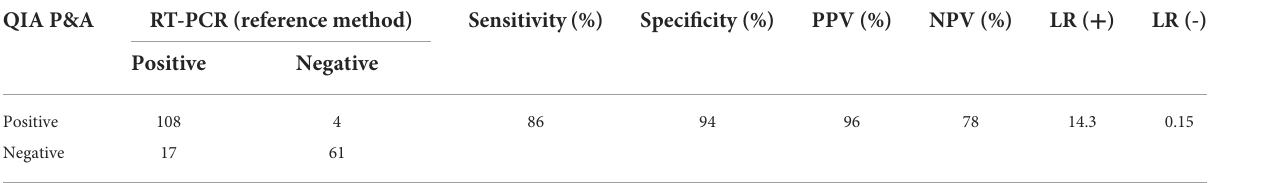
TABLE 3 Comparison between RT-PCR performance (reference method) and QIA P&A. QIA P&A